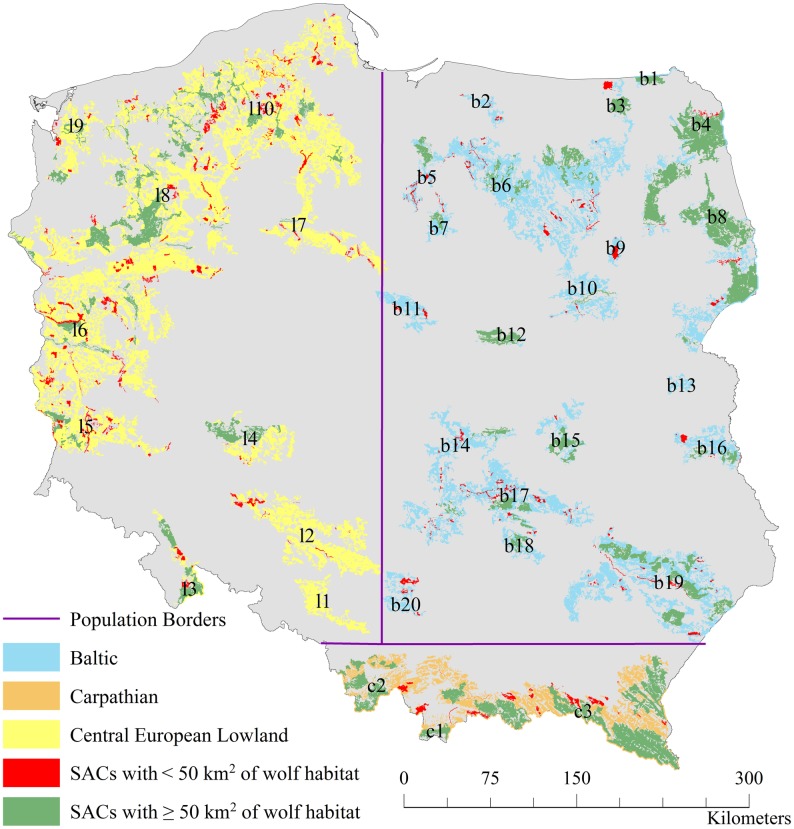
Suitable habitat patches for wolves in Poland.Habitat belonging to populations is shown in blue, orange and yellow. The protected habitat is shown in green and red, denoting areas protected by sites with ≥ 50 km2 of wolf habitat, and areas protected by sites with < 50 km2 of wolf habitat, respectively. Patch labels correspond to those used later in the text.